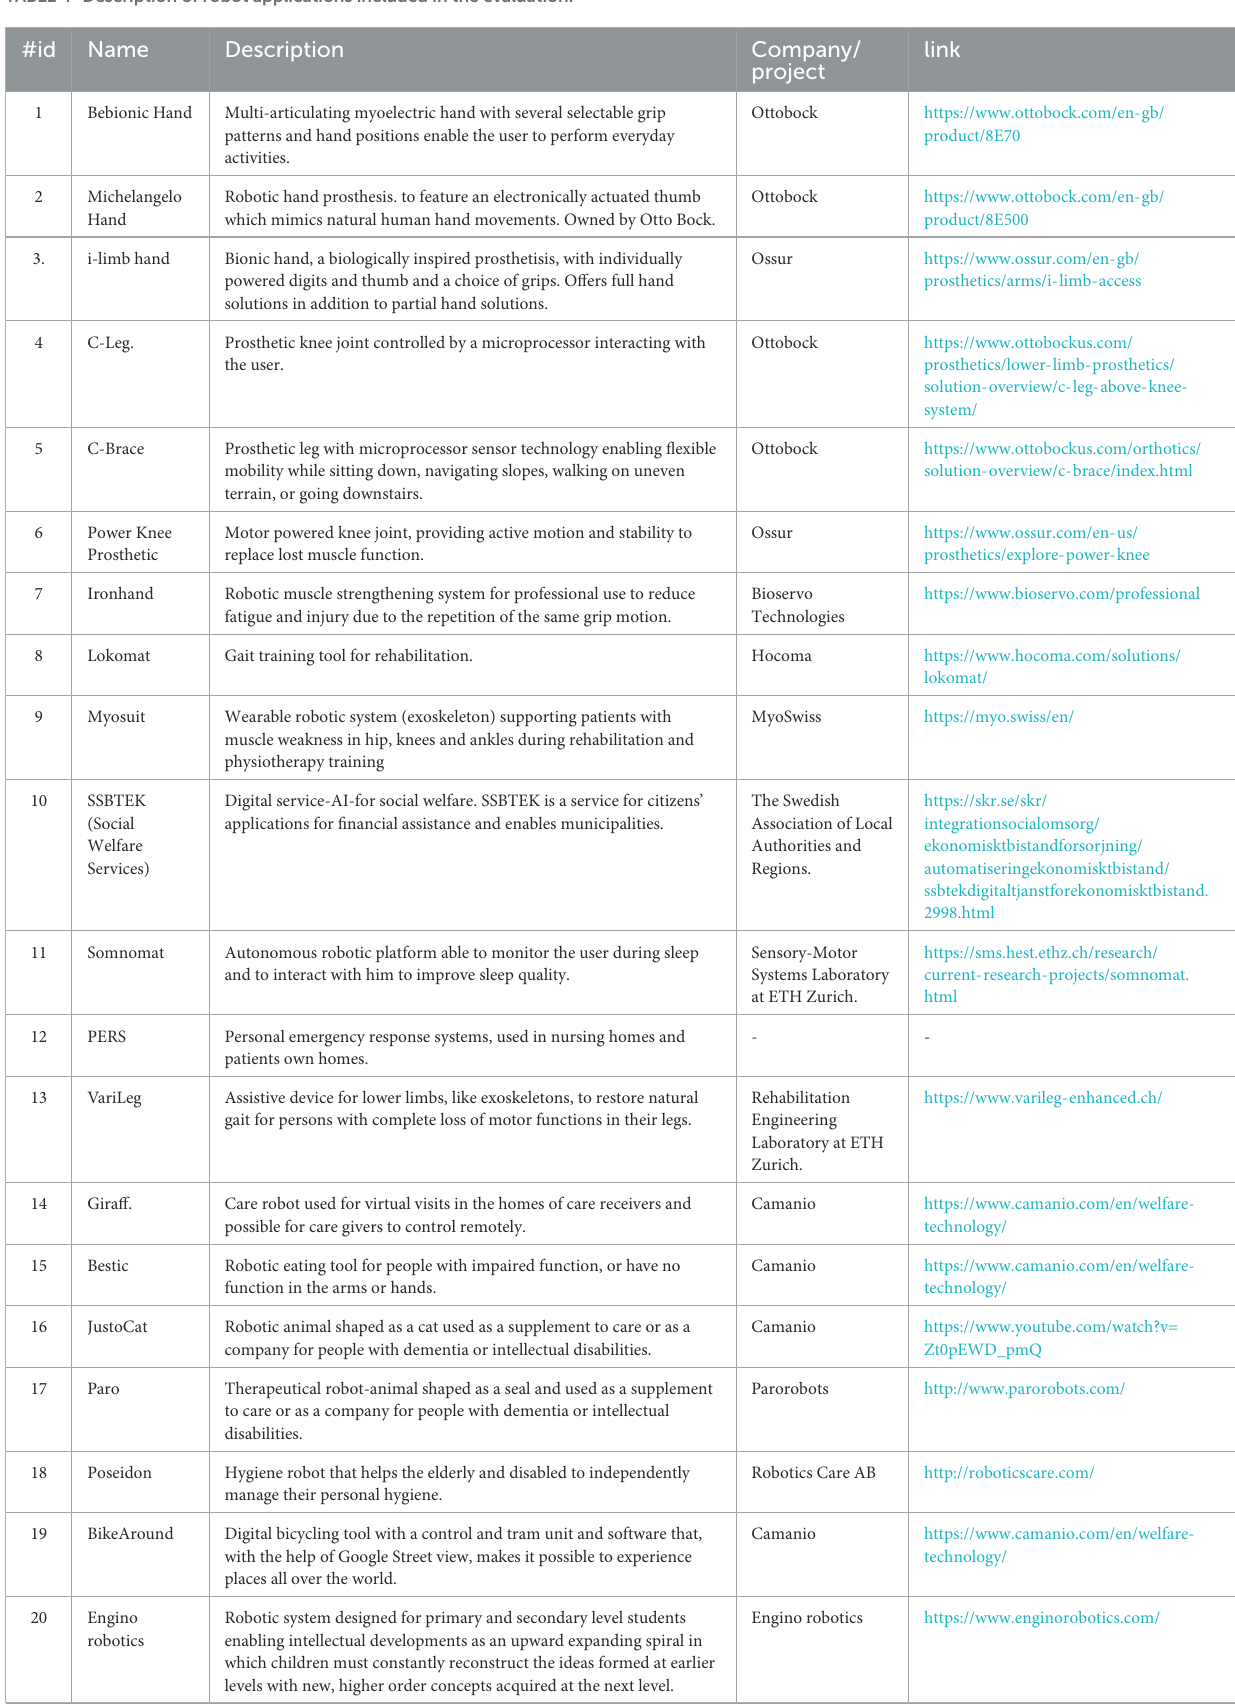
TABLE 4 Description of robot applications included in the